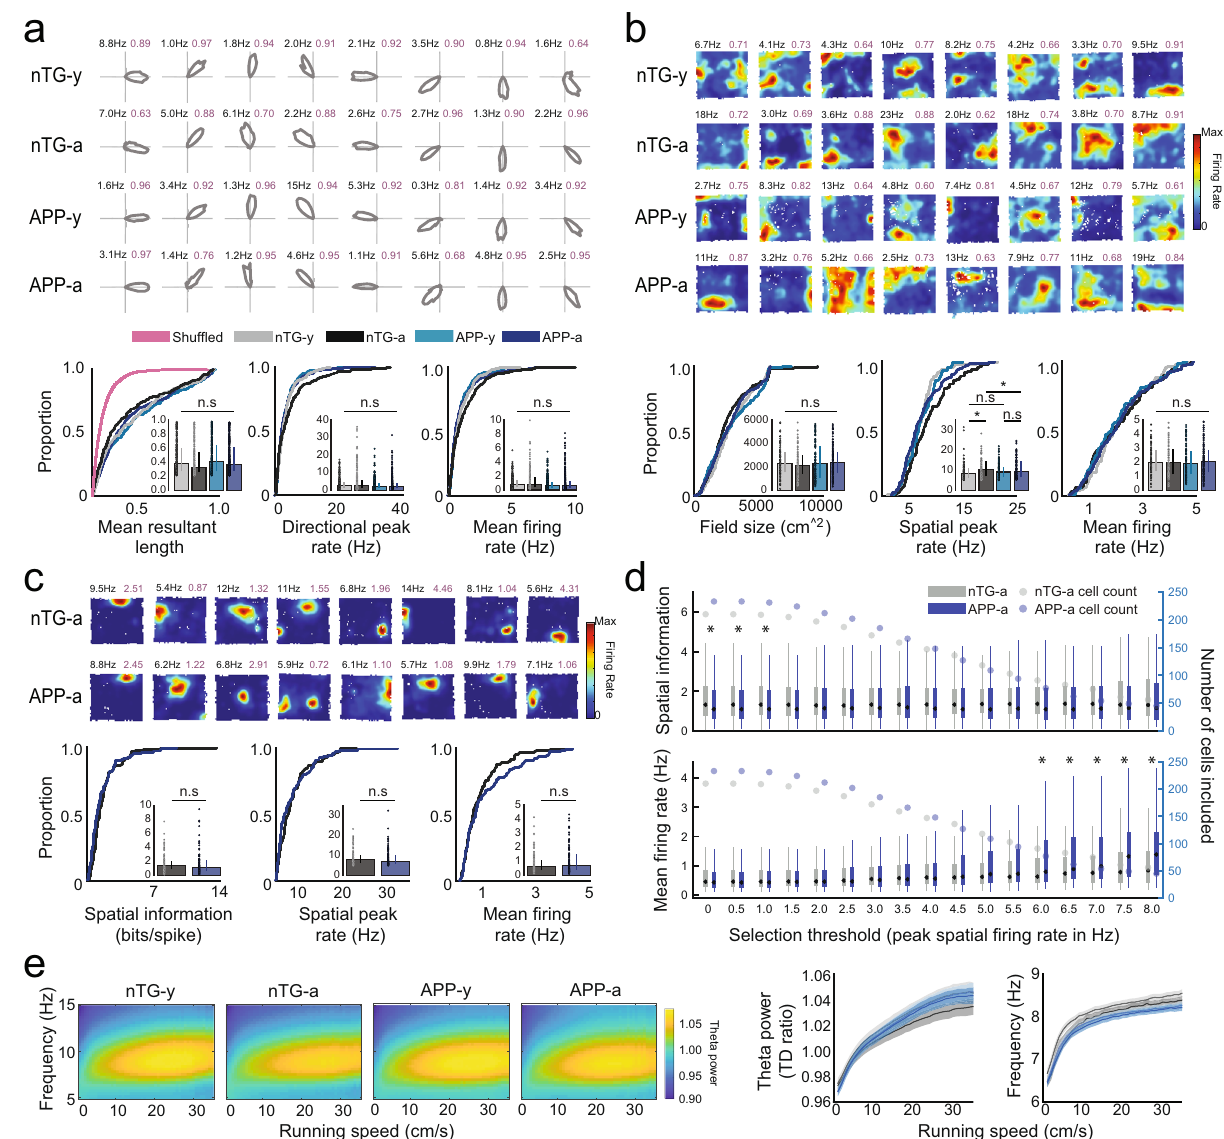
Fig. 2 Head-direction cells, non-grid spatially tuned cells, place cells, and MEC theta oscillations in APP mice. a Head-direction polar plots; peak fi ring rate (F.R) (top-left), mean resultant length (MRL) (top-right). MRL (nTG-y-nTG-a: P = 0.051; nTG-y-APP-y: P = 0.45; APP-y-APP-a: P = 0.41; nTG-a-APP- a: P = 0.11), peak F.R (nTG-y-nTG-a: P = 0.44; nTG-y-APP-y: P = 0.21; APP-y-APP-a: P = 0.96; nTG-a-APP-a: P = 0.073), mean F.R (nTG-y-nTG-a: P = 0.18; nTG-y-APP-y: P = 0.28; APP-y-APP-a: P = 0.87; nTG-a-APP-a: P = 0.08). n = 295 nTG-y; 244 nTG-a; 305 APP-y; 471 APP-a. b Non-grid spatially tuned rate maps; peak F.R (top-left), split-half-reliability (top-right). Field size (nTG-y-nTG-a: P = 0.40; nTG-y-APP-y: P = 0.66; APP-y-APP-a: P = 0.64; nTG-a-APP-a: P = 0.37), peak F.R (nTG-y-nTG-a: P = 0.028; nTG-y-APP-y: P = 0.49; APP-y-APP-a: P = 0.73; nTG-a-APP-a: P = 0.032), mean F.R (nTG-y- nTG-a: P = 0.76; nTG-y-APP-y: P = 0.37; APP-y-APP-a: P = 0.50; nTG-a-APP-a: P = 0.93). n = 82 nTG-y; 83 nTG-a; 106 APP-y; 119 APP-a. c Place cell rate maps; peak F.R (top-left), spatial information (S.I) (top-right). S.I ( P = 0.08), peak F.R ( P = 0.32), mean F.R ( P = 0.31). n = 118 nTG-a; 109 APP-a. d S.I ( P left-to-right: 0.03; 0.03; 0.028; 0.057; 0.10; 0.15; 0.16; 0.28; 0.18; 0.12; 0.08; 0.16; 0.11; 0.12; 0.30; 0.31; 0.41), mean F.R ( P left-to-right: 0.64; 0.64; 0.70; 0.81; 0.95; 0.99; 0.90; 0.82; 0.85; 0.73; 0.31; 0.24; 0.048; 0.016; 0.025; 0.027; 0.039) when varying peak F.R criterion. (nTG-a n left-to-right: 210; 210; 209; 205; 197; 187; 172; 159; 147; 136; 118; 103; 91; 83; 75; 61; 56. APP-a n left-to-right: 233; 233; 231; 224; 212; 202; 185; 166; 148; 127; 109; 94; 77; 62; 54; 49; 45) e MEC theta frequency and power versus running speed. Data are mean ± 99% con fi dence intervals. Wilcoxon rank-sum tests (two-sided) with Bonferroni-Holm ’ s correction were applied to panels a – d . Data in bar graphs are medians ± 25th and 75th percentiles; Boxplots present medians as dots, interquartile boxes from 25th to 75th percentile, whiskers from smallest to largest values; * P < 0.05; n.s not signi fi cant. Source data are provided as a Source Data fi